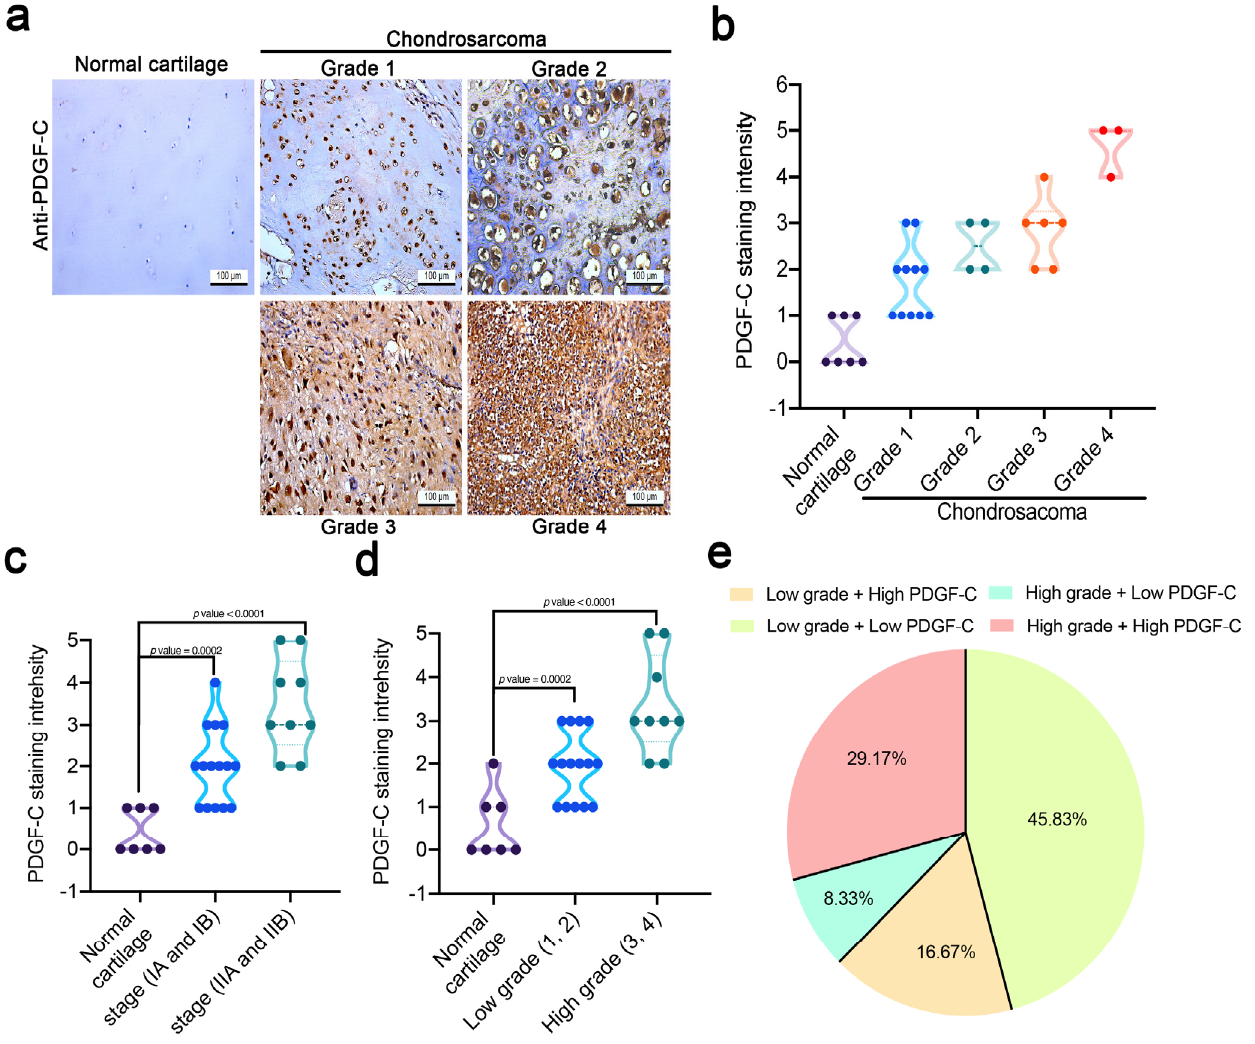
Figure 1. PDGF-C protein expression in normal cartilage and human chondrosarcoma specimens. ( a ) Tissue array showing PDGF-C staining intensities in normal cartilage and chondrosarcoma tissue samples; ( b – d ) histogram graphs showing PDGF-C staining intensities in each type of tissue specimen; ( e ) pie chart distribution of PDGF-C protein levels as determined by IHC analysis in 26 chondrosarcoma samples compared with the normal cartilage